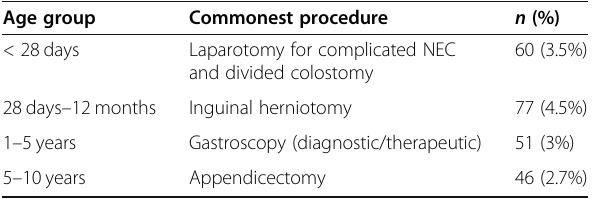
Table 2 Most common paediatric surgical procedures by age group Age